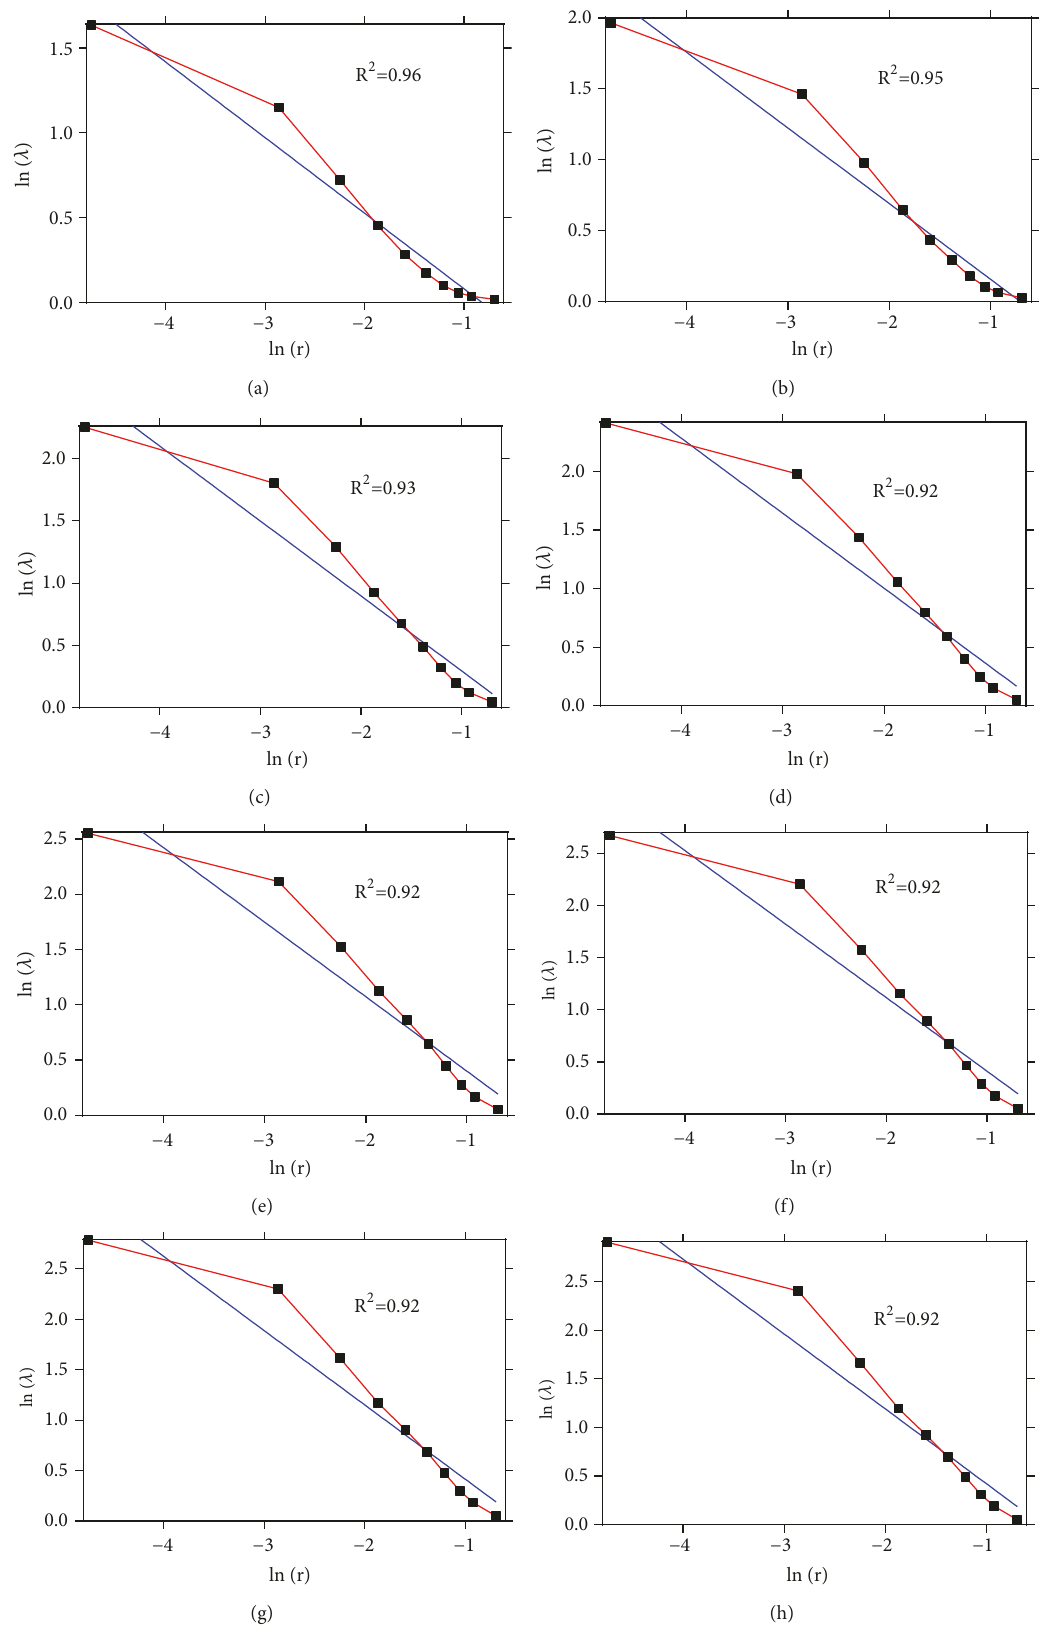
Figure 8: Logarithmic scatter plots of Lacunarity values as a function of gliding box size r using as input the images in Figure 4. (a) (cid:2) 200Ω. m . (b) (cid:2) 220Ω. m . (c) (cid:2) 240Ω. m . (d) (cid:2) 260Ω. m . (e) (cid:2) 280Ω. m . (f) (cid:2) 280Ω. m . (g) (cid:2) 320Ω. m . (h) (cid:2) 340Ω. m